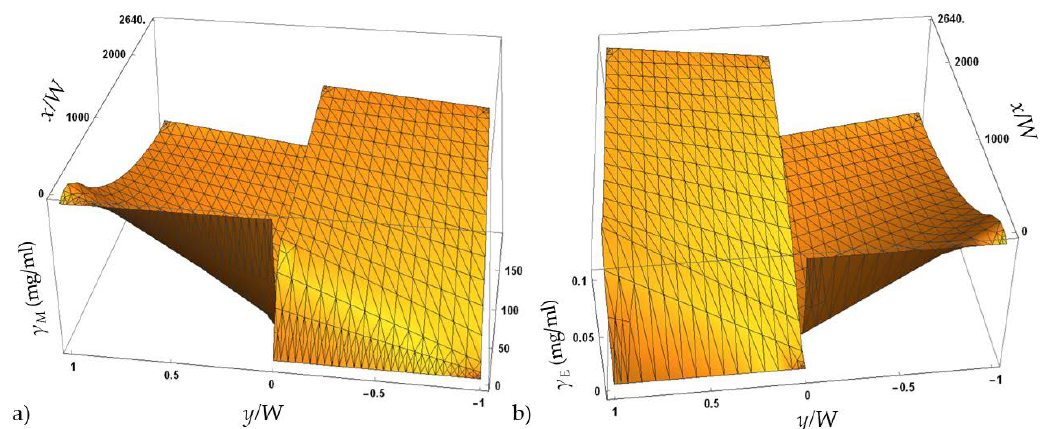
Figure 5. Diffusivity profile for ( a ) methanol and ( b ) enzyme in a microreactor channel for overall flow rate of Φ = 0.03817 μL/min.